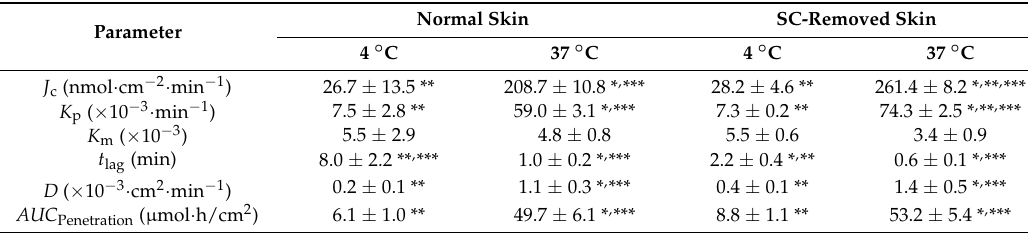
Skin with (normal skin) and without SC (SC-removed skin) was used in this study; the SC was removed by the tape stripping method. The parameter data were analyzed by Equations (1)–(3). n = 6. * p < 0.05, vs. normal skin at 4 °C for each category. ** p < 0.05, vs. normal skin at 37 °C for each category. *** p < 0.05, vs. SC-removed skin at 4 °C for each category.